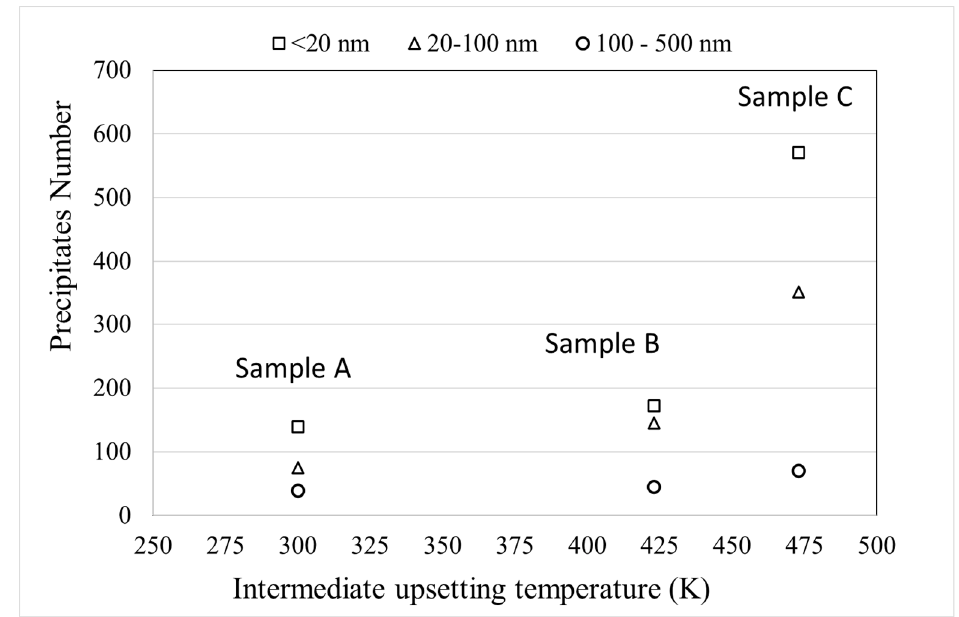
Figure 4. Mean values of precipitates number grouped in size classes (sample A: intermediate upsetting temperature = 293 K; sample B: intermediate upsetting temperature = 423 K; sample C intermediate upsetting temperature = 473 K).